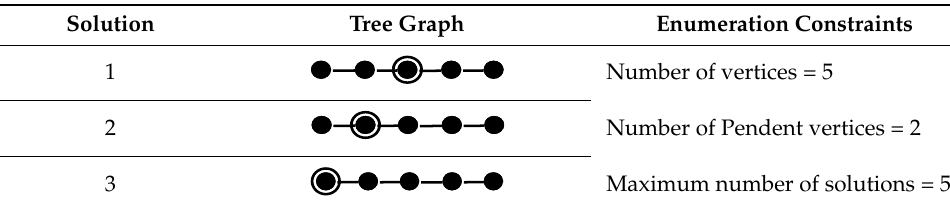
Table 4. Results of generalized layout generation.